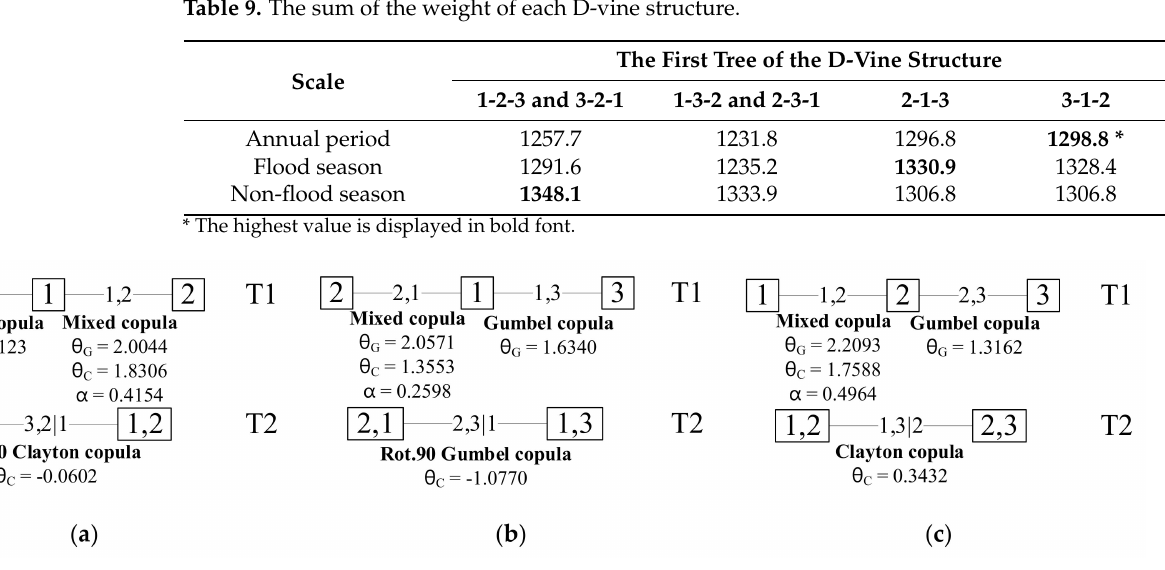
Table 9. The sum of the weight of each D-vine structure.